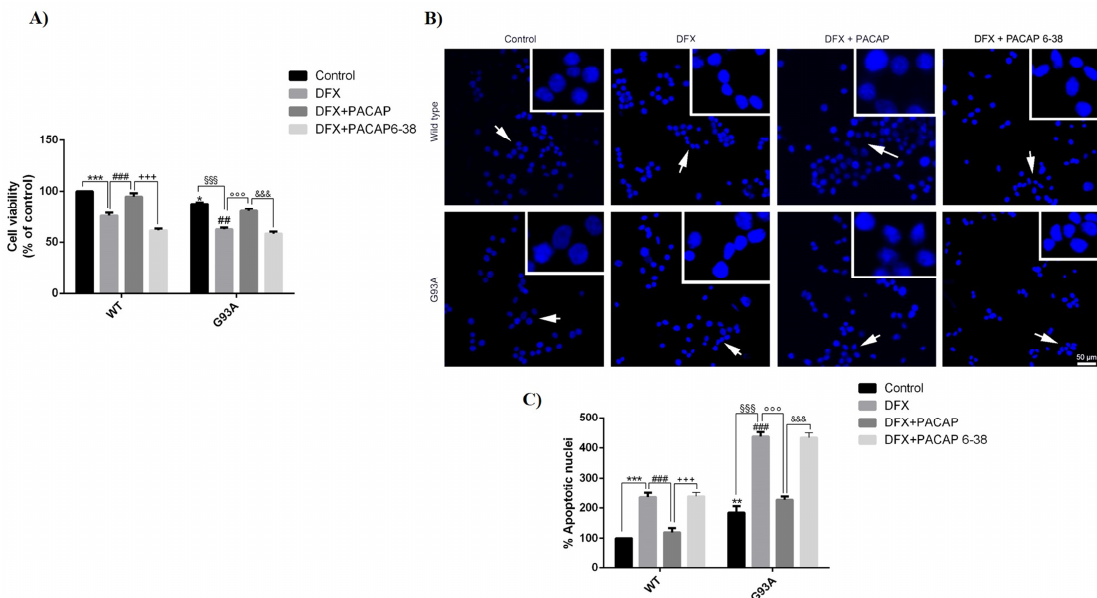
Figure 2. Pituitary adenylate cyclase-activating polypeptide (PACAP) effect on the WT and G93A cell